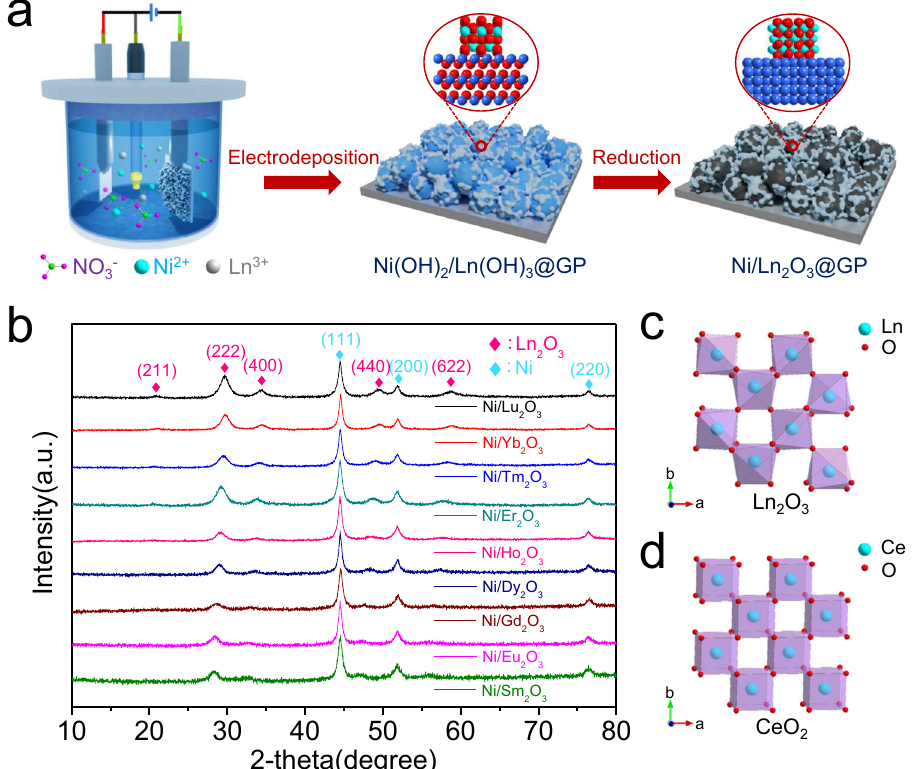
Fig. 1 Preparation and phase analysis of electrodes. a Synthetic scheme of graphite plate supported Ni/Ln 2 O 3 electrodes. b XRD patterns of Ni/Ln 2 O 3 hybrids. c Crystal structure of bixbyite-type Ln 2 O 3 . d Crystal structure of fl uorite-type CeO 2